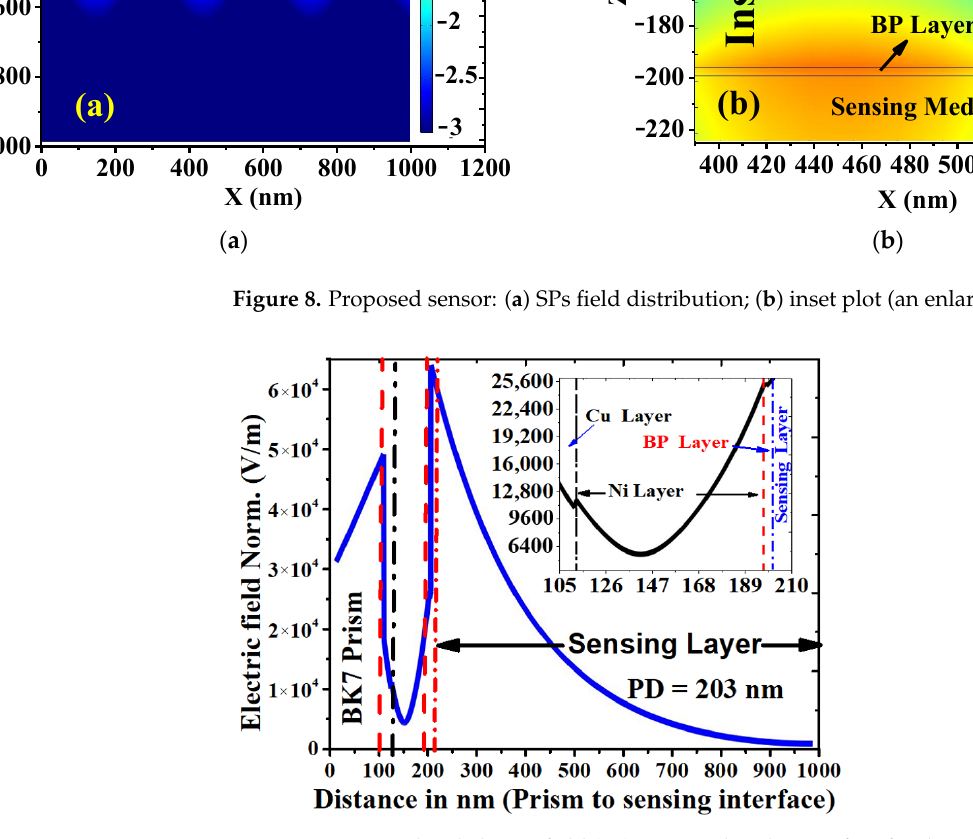
Figure 9. A normalized electric field (E y ) is normal to the interface for the proposed sensor. The inset shows the enlarged view.